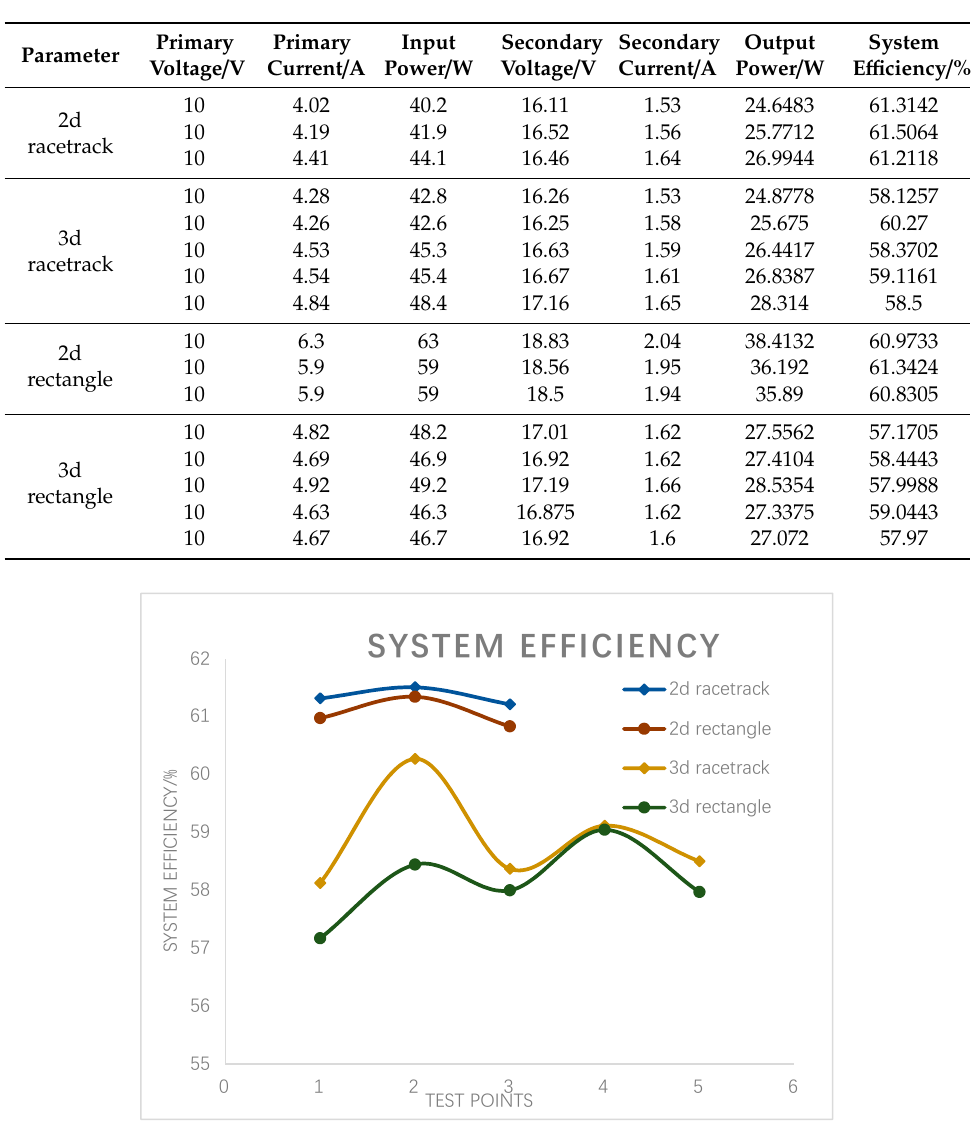
Table 6. Test data for di ff erent tracks.